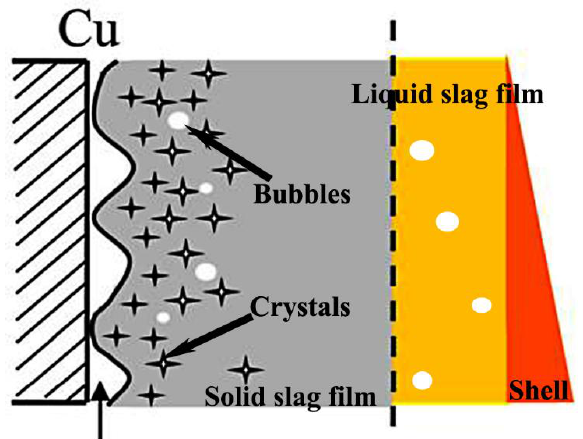
Figure 1. Schematic diagram of mold fluxes at the meniscus region.